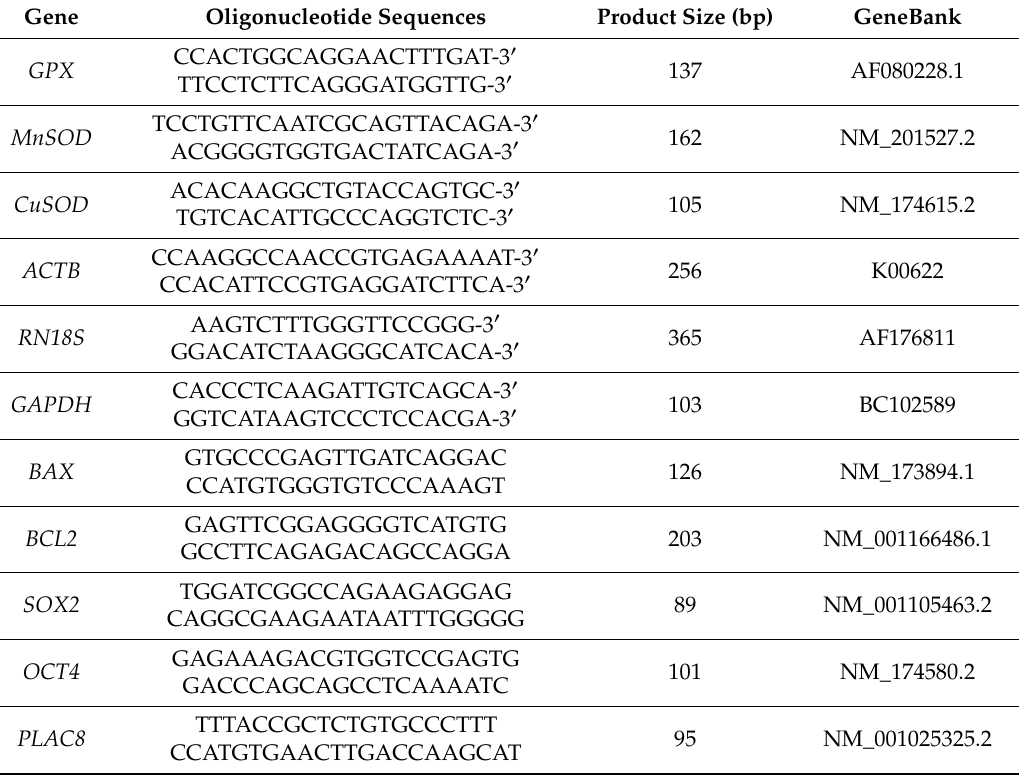
Table 1. Oligonucleotide sequences used for real-time polymerase chain reaction